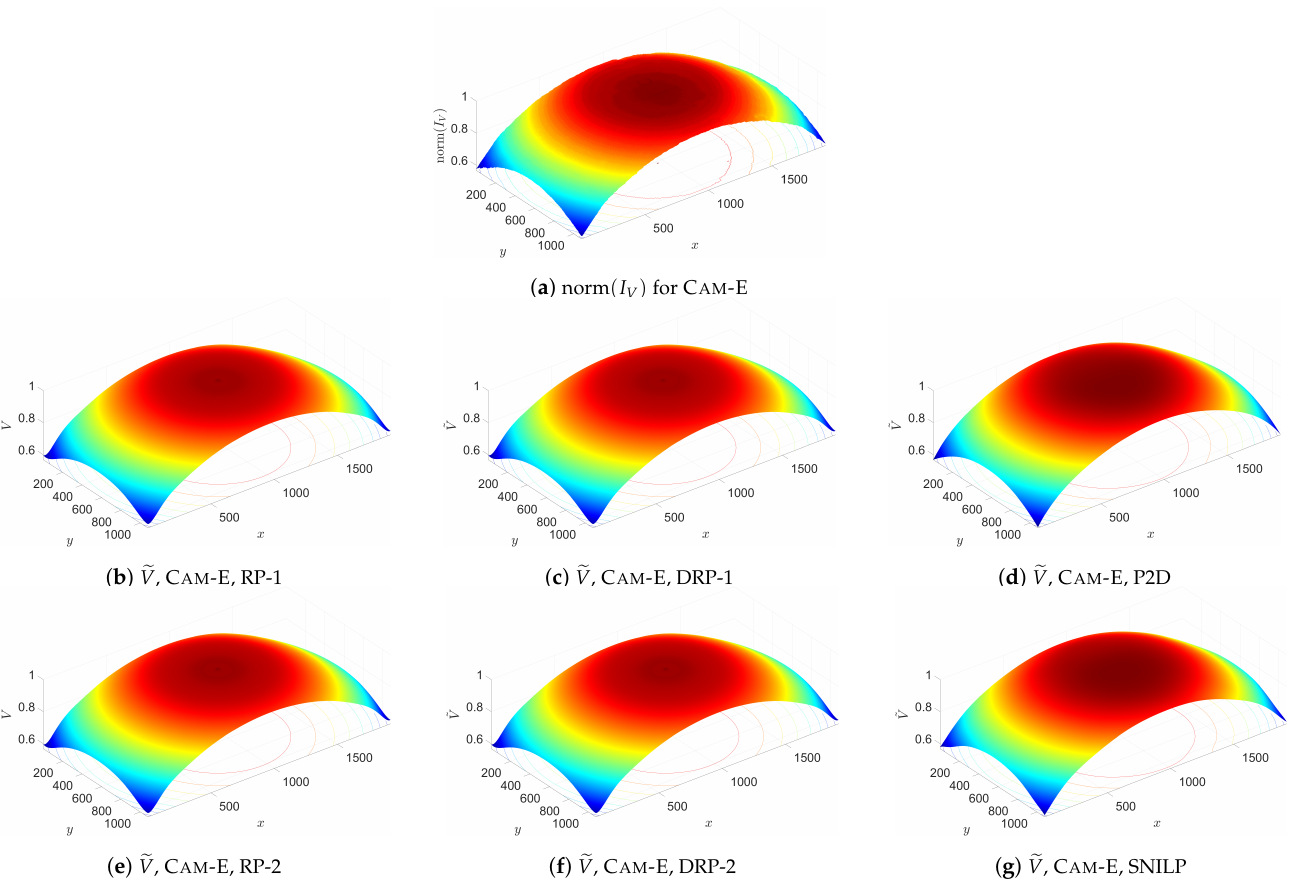
Figure A9. Comparison of vignetting image I V and vignetting estimates (cid:101) V obtained for the tested models and C AM -E.